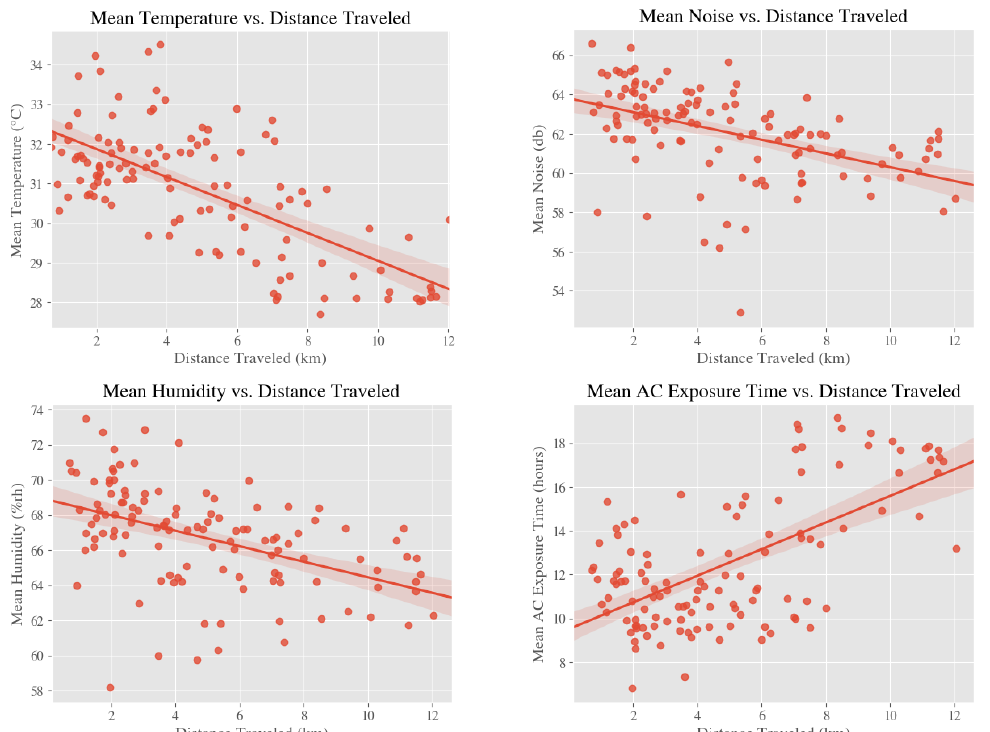
Figure 1. Relationships between environmental exposures and distance traveled between home and